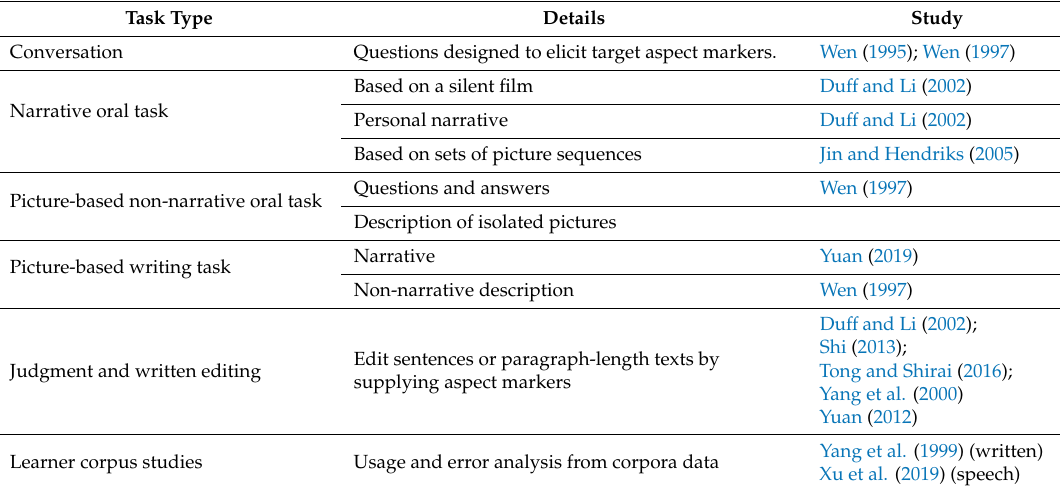
Table 2. Tasks used in previous L2 studies of perfective - le